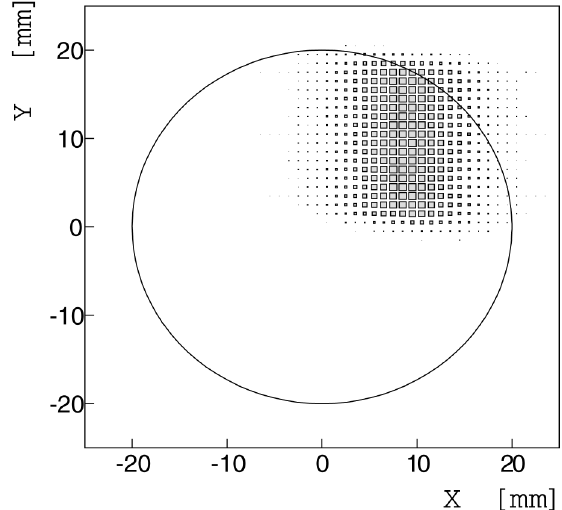
4. Example of the wattage distributions at the IP in the plane perpendicular to the beam axis. The X axis is taken to be in the horizontal direction, pointing to the outside of the KEKB ring, and Y in the vertical direction. The SR comes from the vertical BEND located about 25 m upstream from the IP. The circle in the figure corresponds to the inner surface of the IP